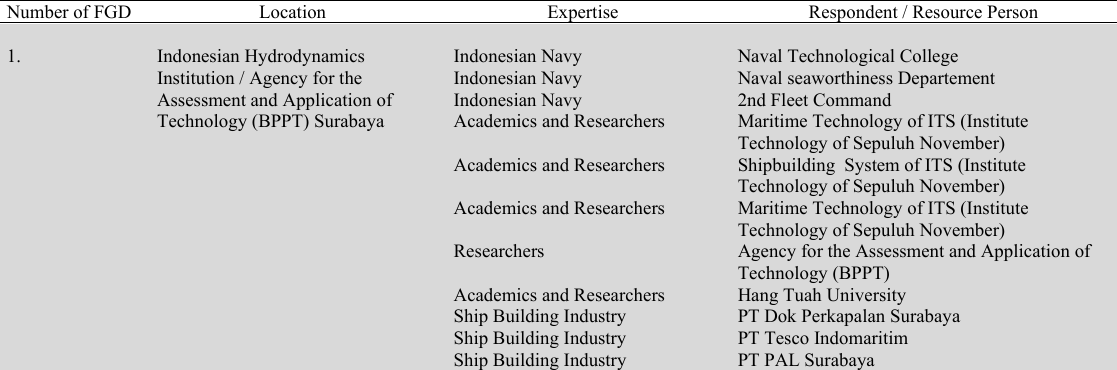
Focus Group Discussion (FGD) and research